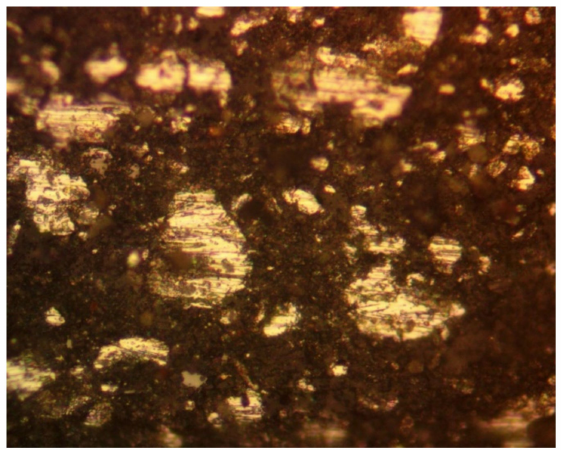
Figure 8. Photomicrograph of a freshly manufactured pellet. Polished surface, reflected light. Field of view = 0.1 mm. White areas are polished Fe 0 metal. Brown/black areas show porosity coated in n-Fe-polymer@n-C 0 polymer. The cross-sectional porosity is about